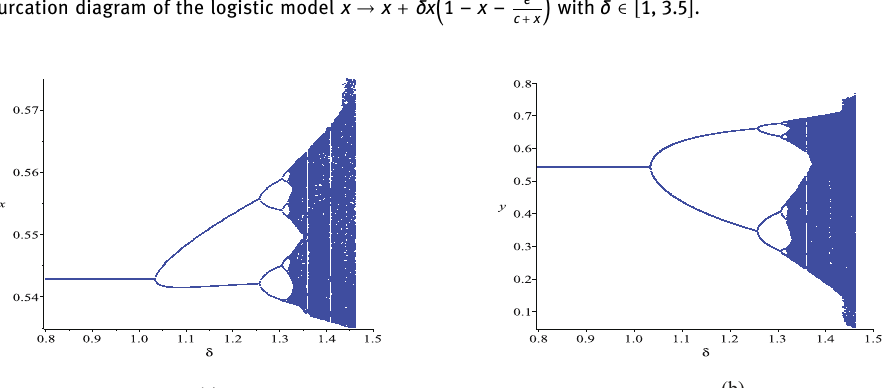
Figure 2: Bifurcation diagram of the logistic model x